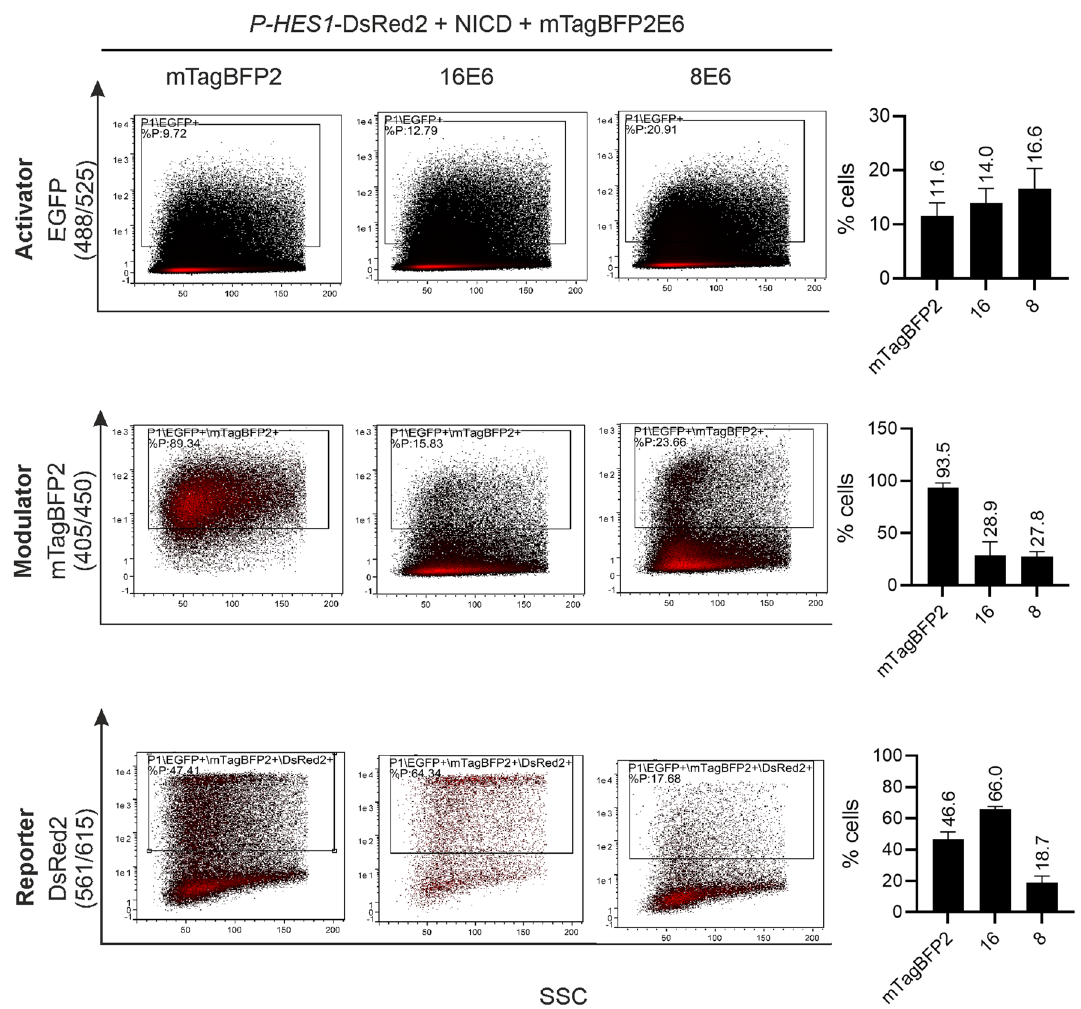
Figure 6. Experimental triple gating strategy, exemplary for Notch activation (16E6) and repression (8E6). C33A cells were co-transfected with 250 ng P-HES1 -DsRed2 reporter plasmid, 250 ng NICD activator plasmid, 500 ng mTagBFP2-E6 modulator plasmid respectively or 125 ng of mTagBFP2 as a control. Cells were harvested for FACS measurement 48 h post transfection. Living cells were gated for P1/EGFP > P1/EGFP/mTagBFP2 > P1/ EGFP/mTagBFP2/DsRed2 to monitor the activity of P-HES1 . The mean % cells of cell population as gated for three independent biological replicates were plotted to the right of the representative FACS plots. The mean values were stated above each bar and the error bars indicate the standard deviation of the mean value from the three independent biological